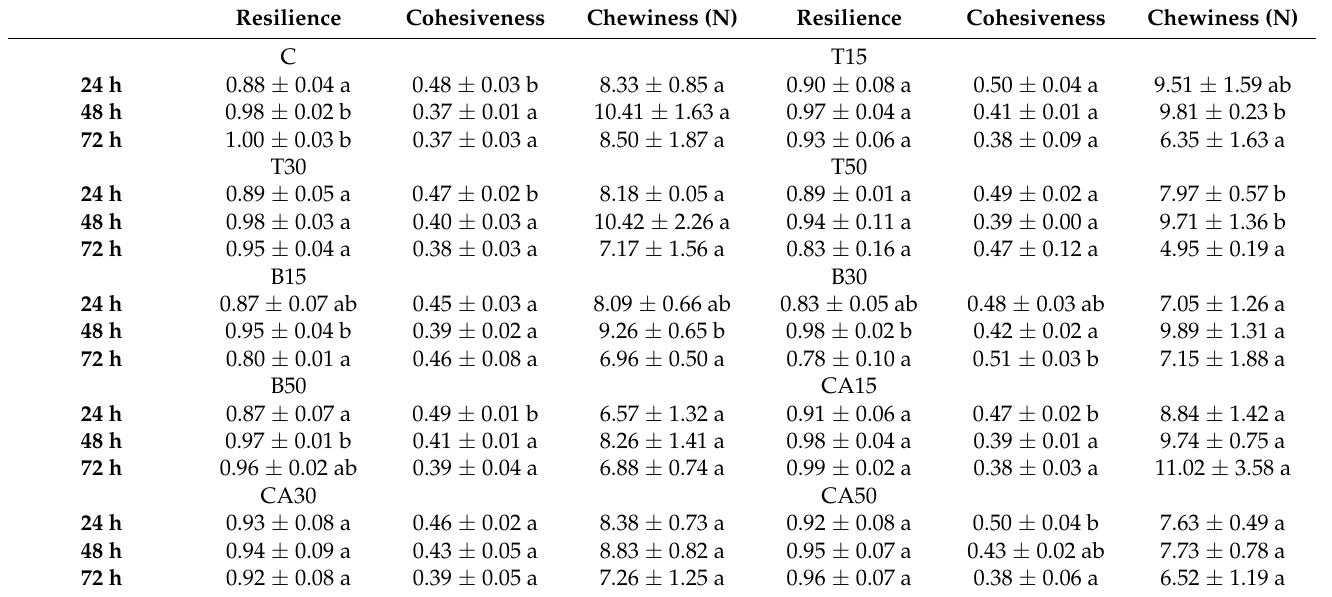
Values represent means ± standard deviation ( n = 6, for each bread type). For each bread, the values in a column with different letters are significantly different ( p < 0.05).